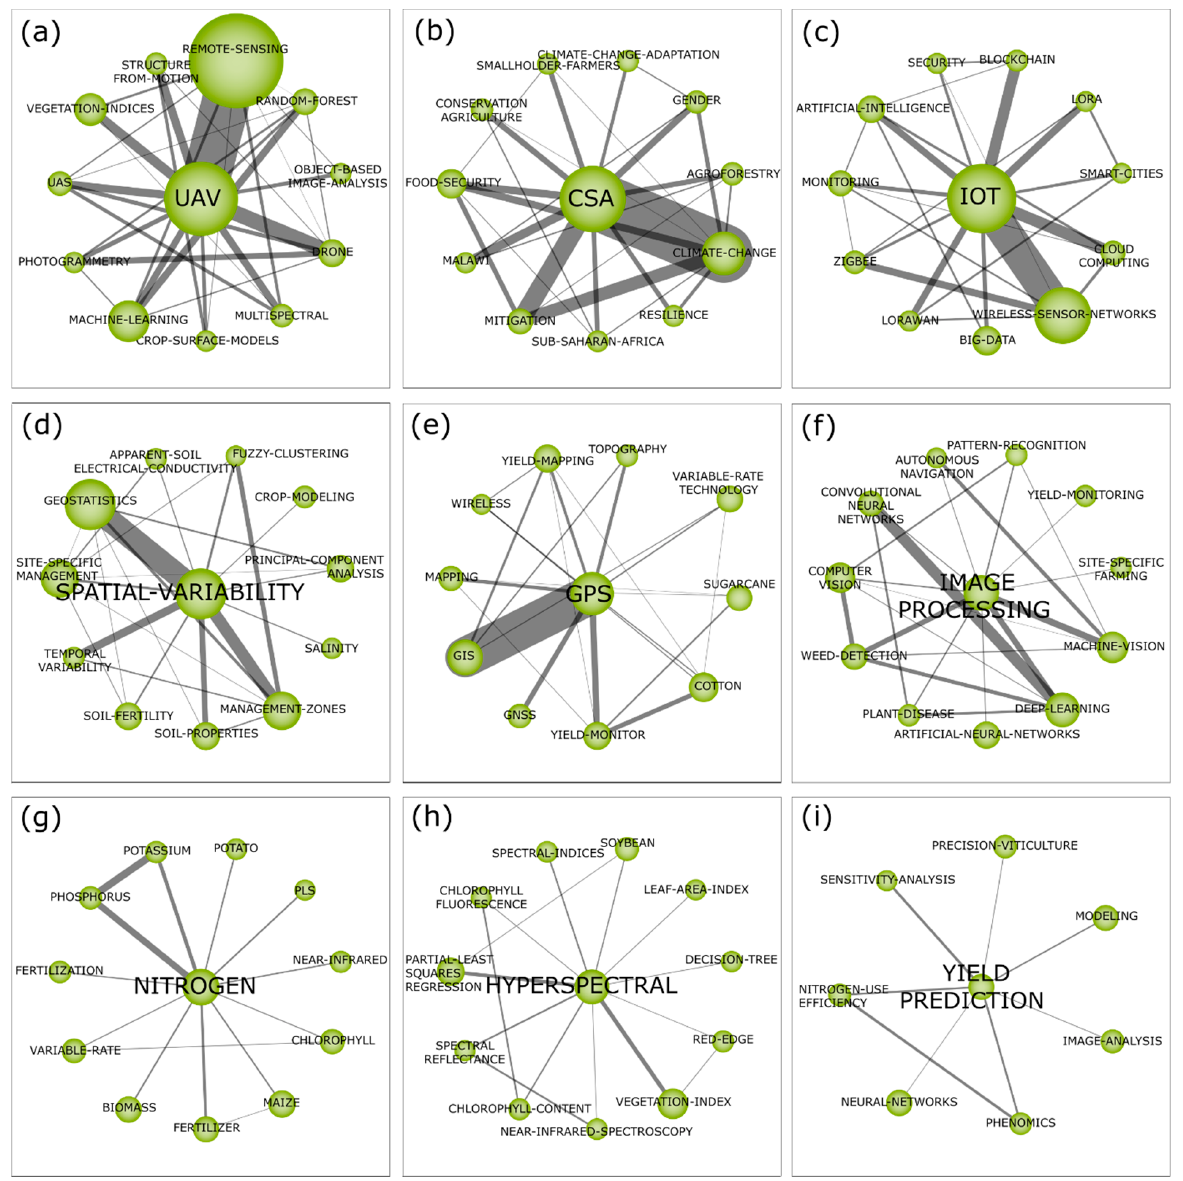
Figure 4. Thematic network structures. ( a ) UAV; ( b ) CSA; ( c ) IoT; ( d ) Spatial Variability; ( e ) GPS; ( f ) Image Processing; ( g ) Nitrogen; ( h ) Hyperspectral; ( i ) Yield Prediction.